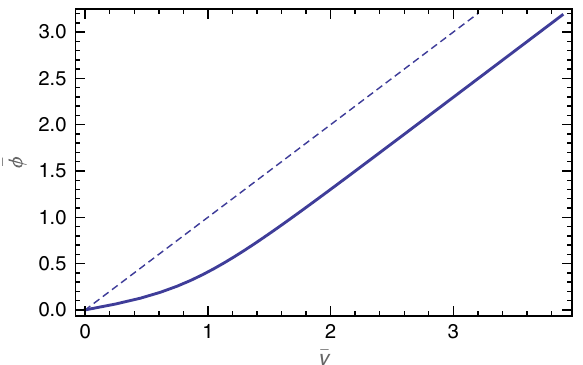
(cid:1) (cid:5) versus (cid:1) y for x ¼ 0 (solid (cid:1) (cid:5) ¼ (cid:1) y . The vertical distance between (cid:1) (cid:5) 0 . (cid:1) (cid:5) ð (cid:1) y Þ at (cid:1) x ¼